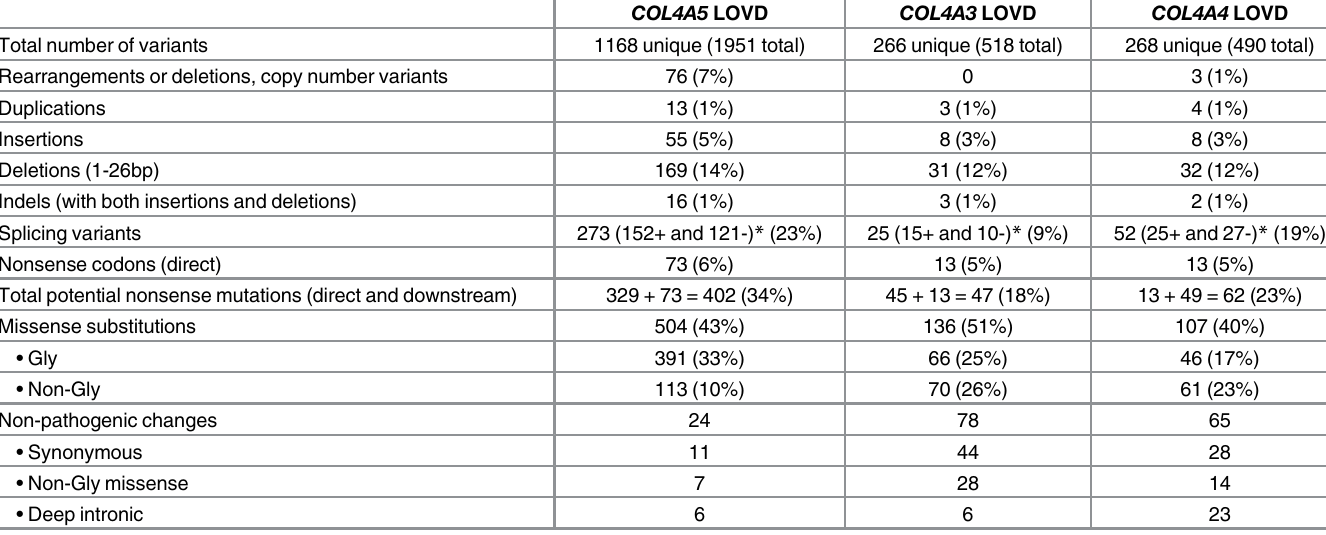
Table 2. Frequency of variants in COL4A5 , COL4A3 and COL4A4 genes in LOVD databases.